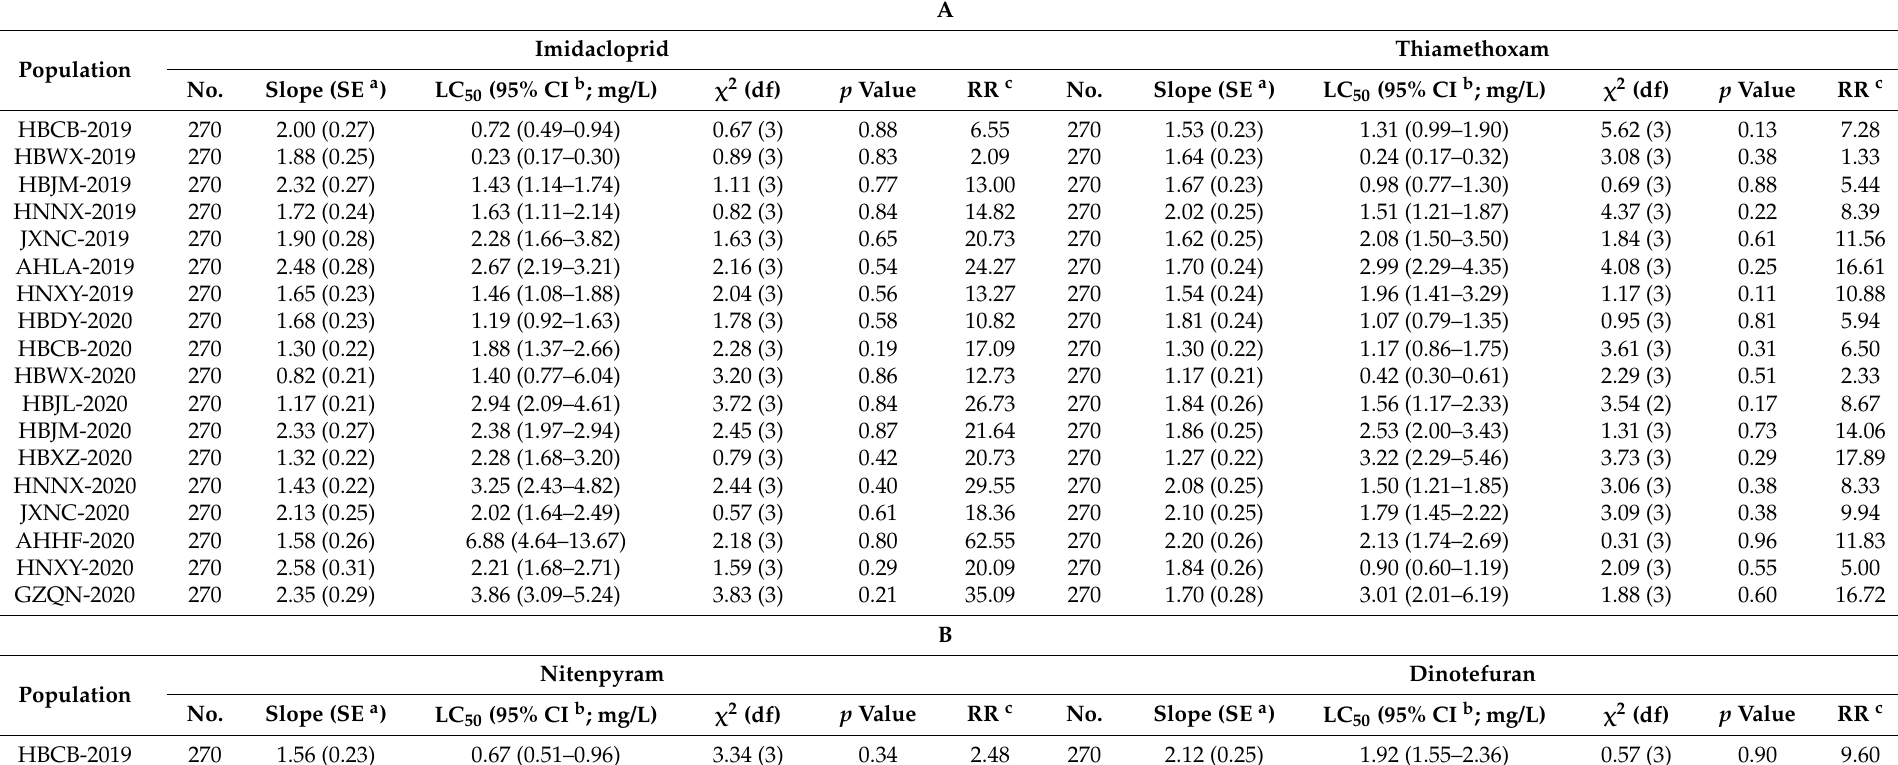
Table 3. Resistance levels of S. furcifera field populations to insecticides, including ( A ) imidacloprid and thiamethoxam, ( B ) nitenpyram and dinotefuran, ( C ) clothianidin and sulfoxaflor, ( D ) buprofezin and chlorpyrifos, ( E ) isoprocarb and